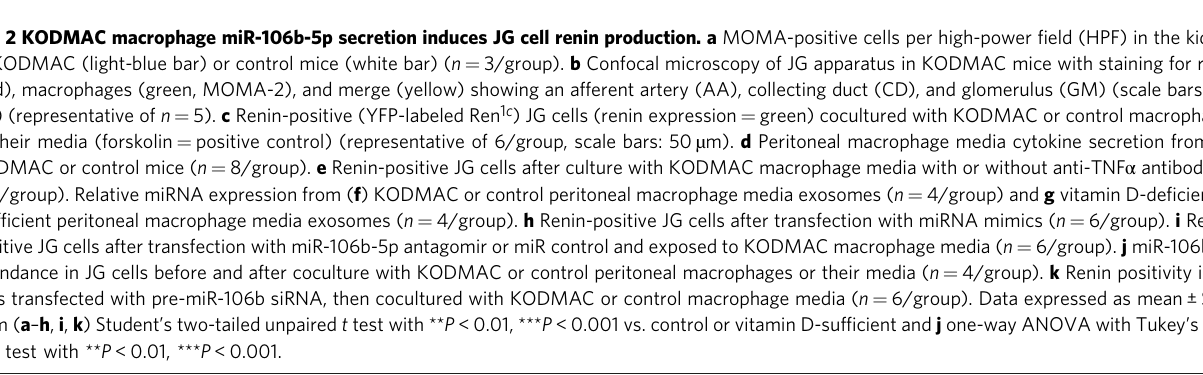
Fig. 2 KODMAC macrophage miR-106b-5p secretion induces JG cell renin production. a MOMA-positive cells per high-power fi eld (HPF) in the kidney of KODMAC (light-blue bar) or control mice (white bar) ( n = 3/group). b Confocal microscopy of JG apparatus in KODMAC mice with staining for renin (red), macrophages (green, MOMA-2), and merge (yellow) showing an afferent artery (AA), collecting duct (CD), and glomerulus (GM) (scale bars: 50 µ m) (representative of n = 5). c Renin-positive (YFP-labeled Ren 1 c ) JG cells (renin expression = green) cocultured with KODMAC or control macrophages or their media (forskolin = positive control) (representative of 6/group, scale bars: 50 µ m). d Peritoneal macrophage media cytokine secretion